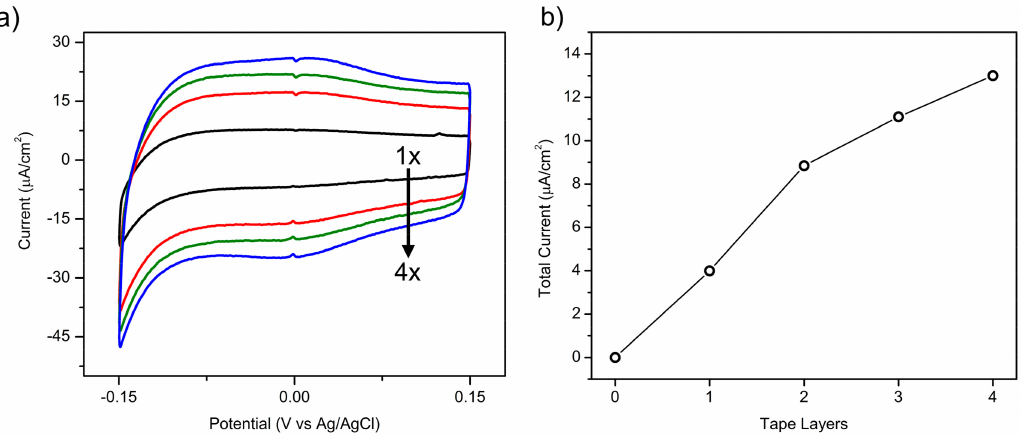
Figure 4. ( a ) Cyclic voltammograms of cyt c soaked meso-macroporous ATO coatings with varying thicknesses. ( b ) Mask thickness vs. total current of cyt c soaked